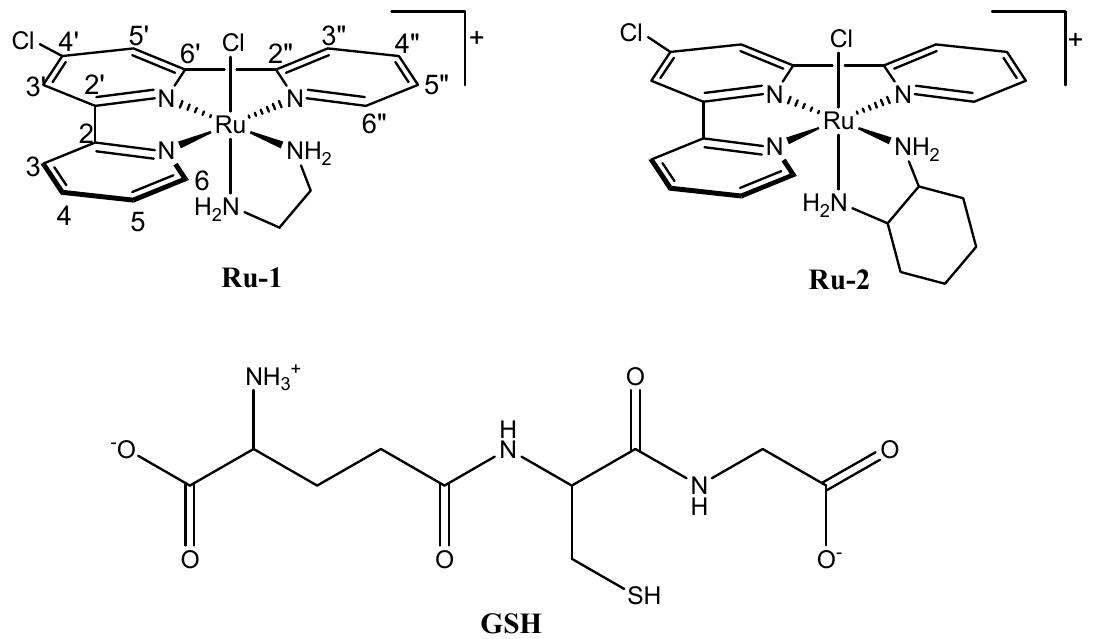
Figure 1. Schematic structures of the ruthenium(II) terpyridine complexes Ru-1 and Ru-2 and of the tripeptide glutathione ( γ - L -Glu- L -Cys-Gly; GSH).